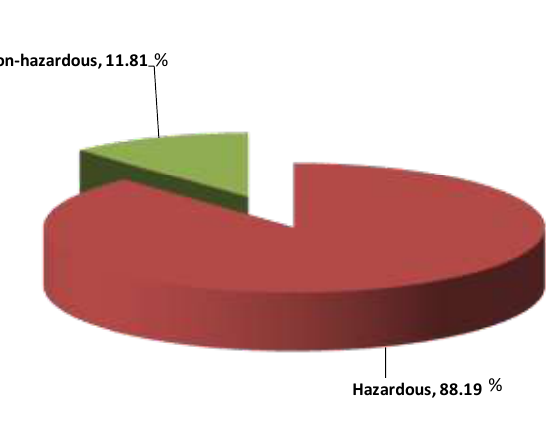
Figure 5: waste classification based on hazardous